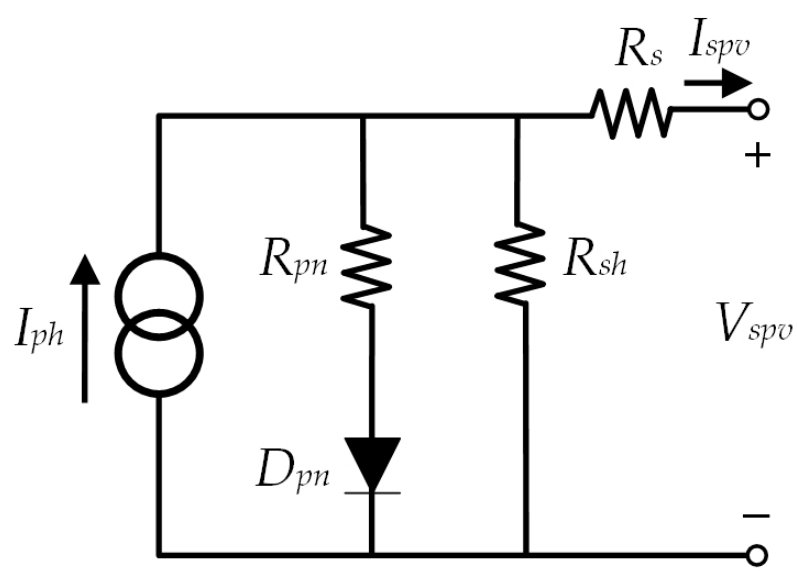
Figure 2. The equivalent circuit of a single SPVC.